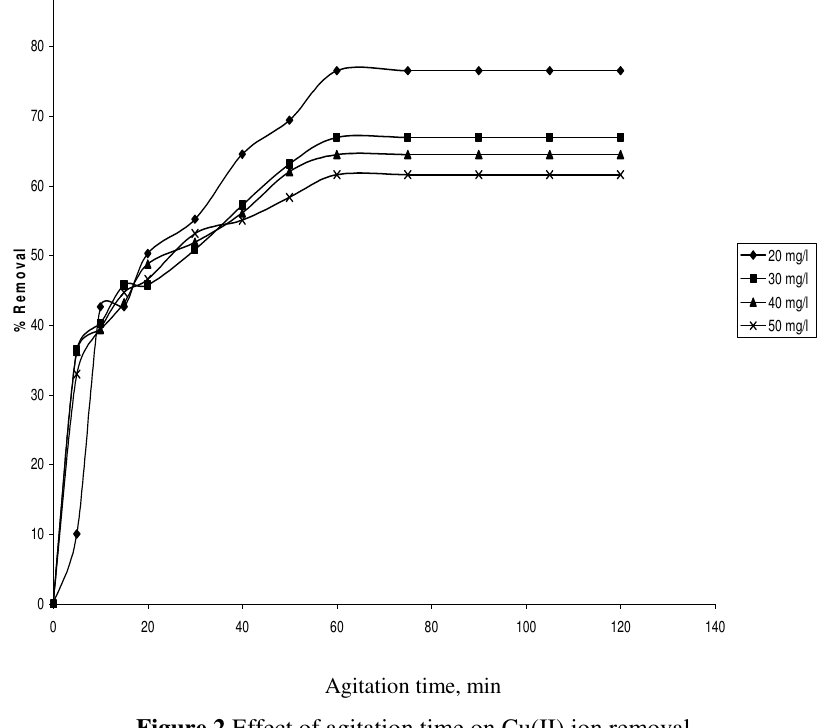
Figure 2 Effect of agitation time on Cu(II) ion